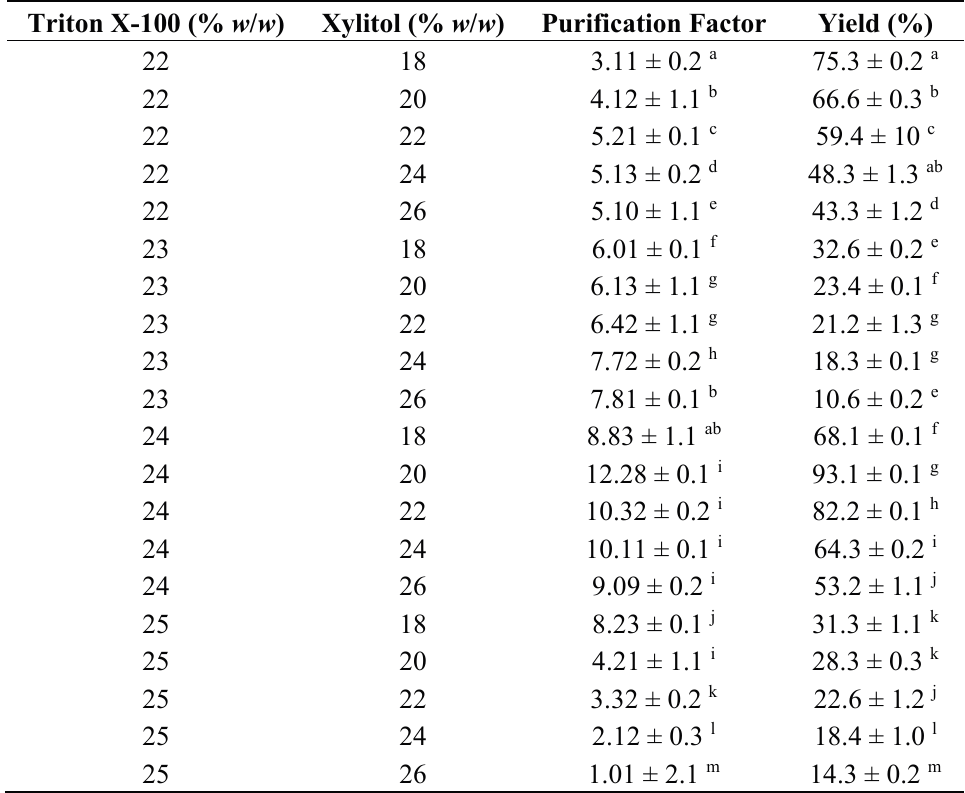
Table 3. Partition of lipase in different concentrations of Tritonx-100/xylitol